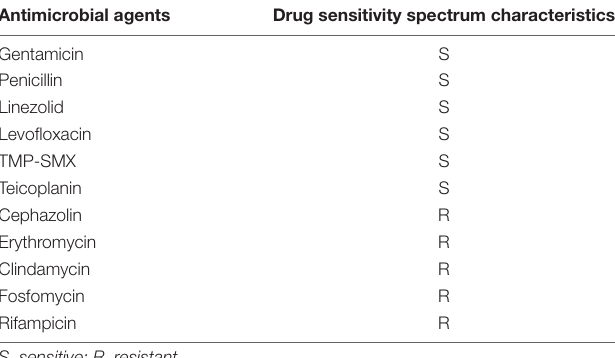
spine. In total, 23 patients presented with fever, cough, dyspnea, malaise, and weight loss. Among them, 13 patients with brain abscesses presented with fever, cough, dyspnea, headache, and